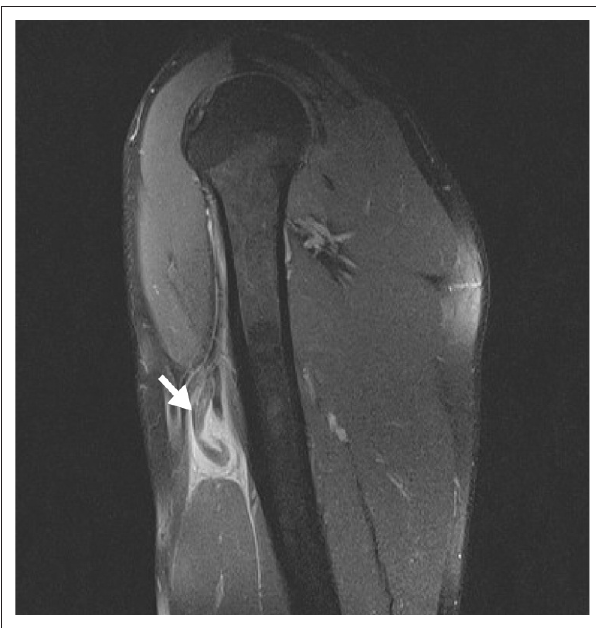
FIGURE 2: Magnetic resonance image (MRI) PD TSE FS in the sagittal plane, demonstrating the retracted tendon in the upper arm (arrow).